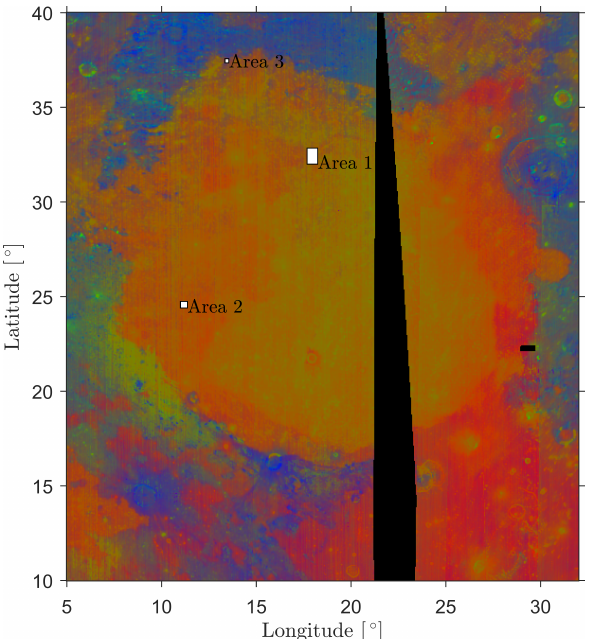
Figure 1: Petrographic map of Mare Serenitatis. The petro- graphic map is based on the Fe and Mg content of the surface following three endmember model of Berezhnoy et al. (2005). The three endmembers are used to create a color composite (Red: basaltic material, Green: Mg-rich rock, Blue: feldspathic mate- rial). The three regions considered in this study are shown as white rectangles. Black denotes missing